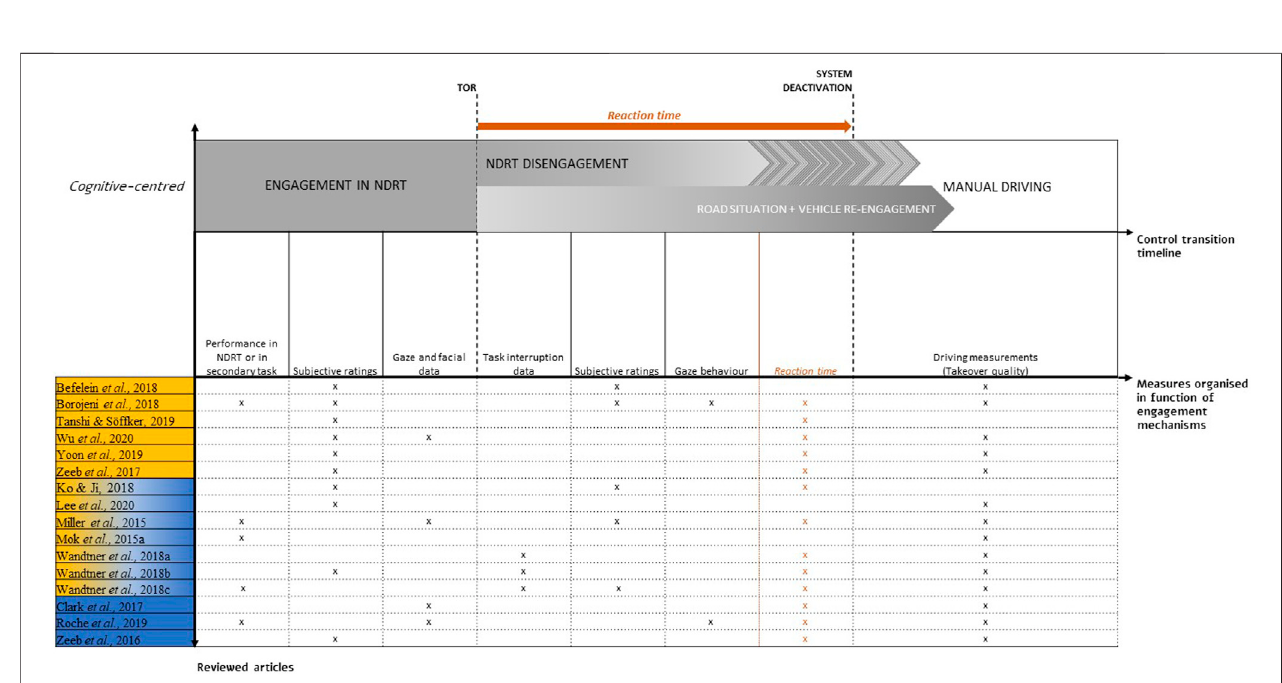
FIGURE 5 | Illustration of the attribution of reviewed articles measurements to each control phase according to engagement mechanisms.